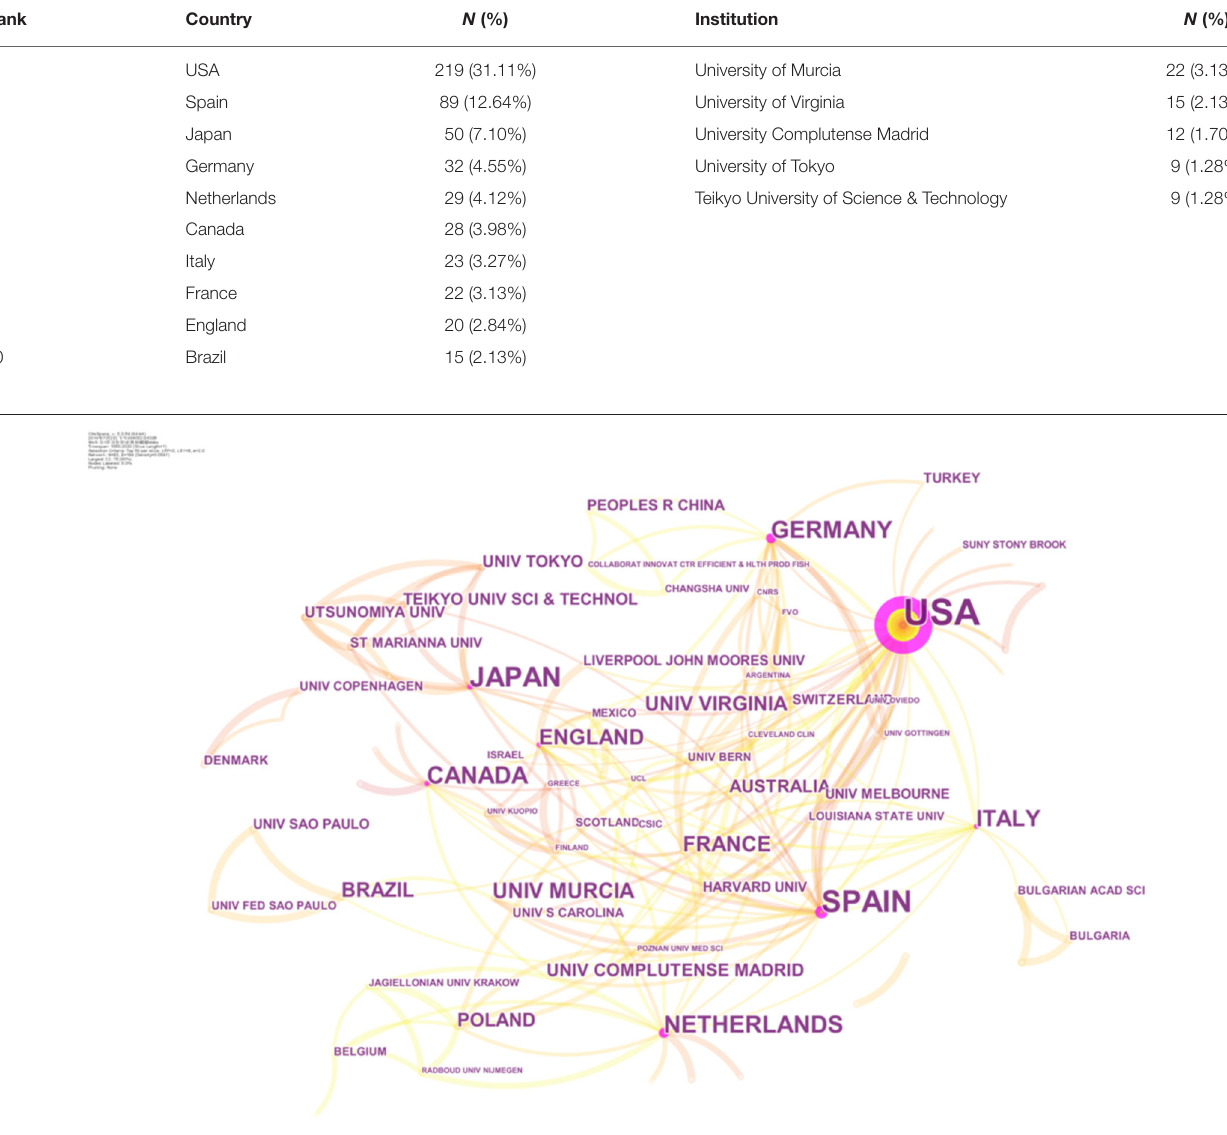
FIGURE 4 | The network of countries and institutions.